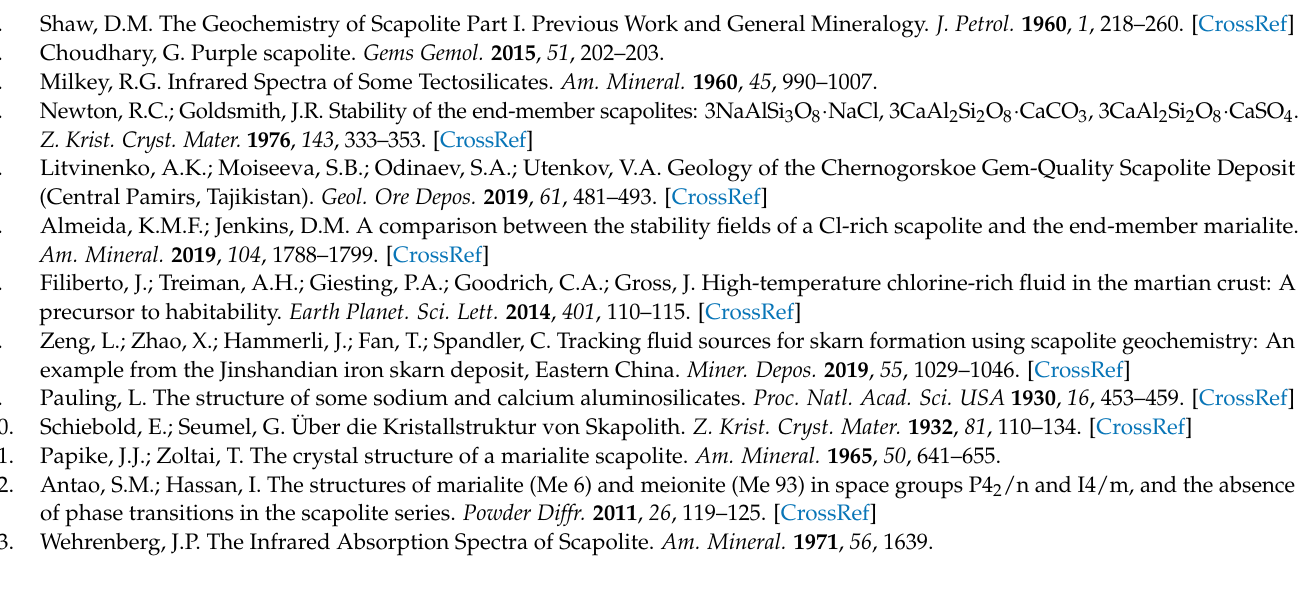
XRF test results of scapolite; supporting document Table S2: EPMA test results of scapolite; support- ing document Table S3: ICP-MS test results of